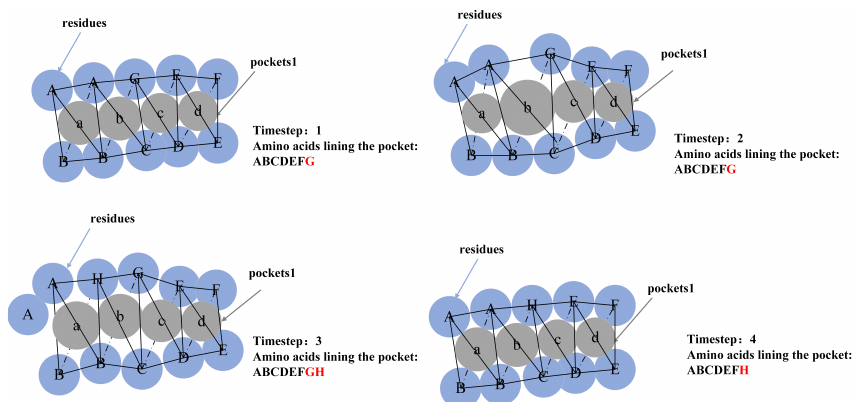
Figure 4. Amino acids lining the dynamic